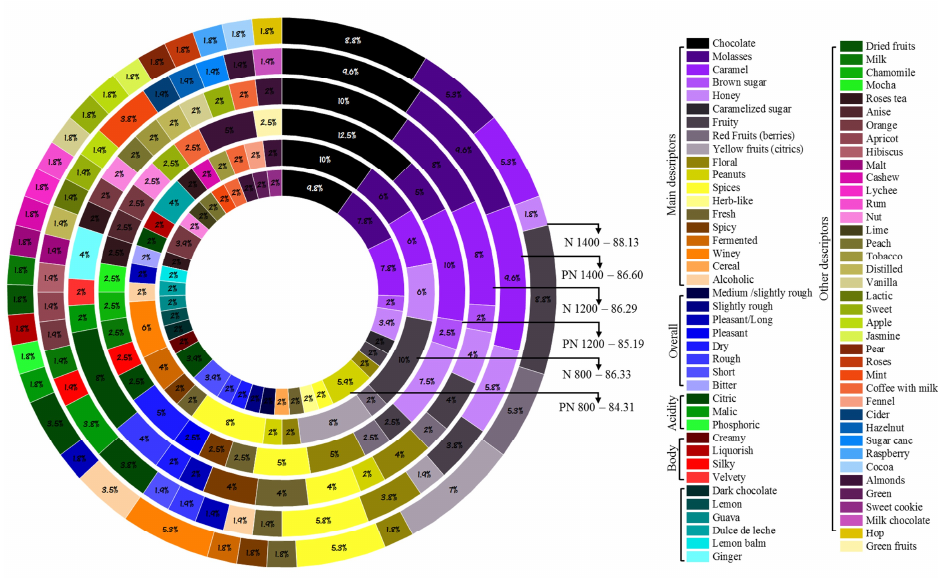
Figure 6. Sensory notes and descriptor occurrences were expressed in percentage for each altitude within each